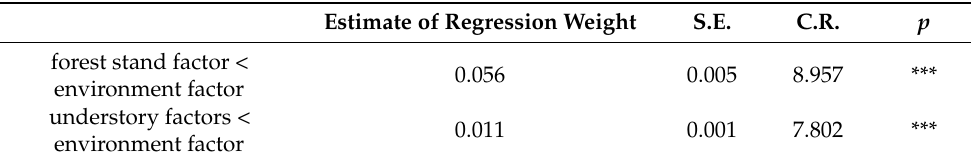
Table 5. Latent variable